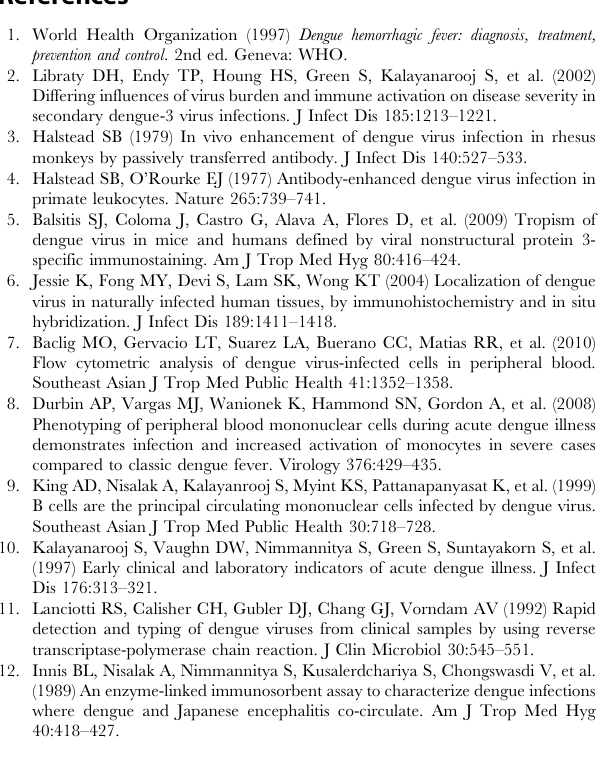
Table S4 DENV RNA in C6/36 cells detected by positive and negative strand